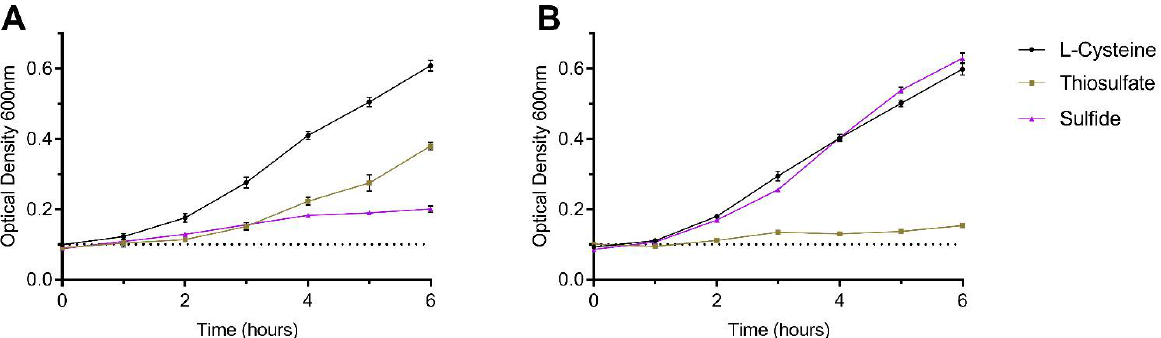
Figure 5. Growth of C. jejuni NCTC11168 wildtype on defined sulfur sources. Sulfur deficient defined media with individual sulfur sources added to either ( A ) 2 mM final, added in total at T0, or ( B ) 0.1 mM total, added progressively every hour over the course of 6 h. The inoculum level is indicated by the dashed line.